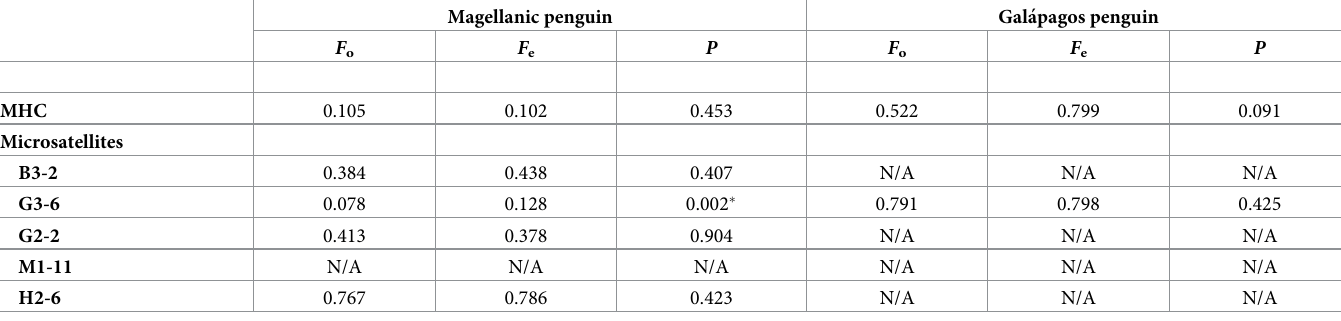
Table 4. Summary of Magellanic and Gala´pagos penguin Ewens-Watterson tests for all MHC class II DR β 1 and microsatellite loci. Ewens-Watterson observed F (